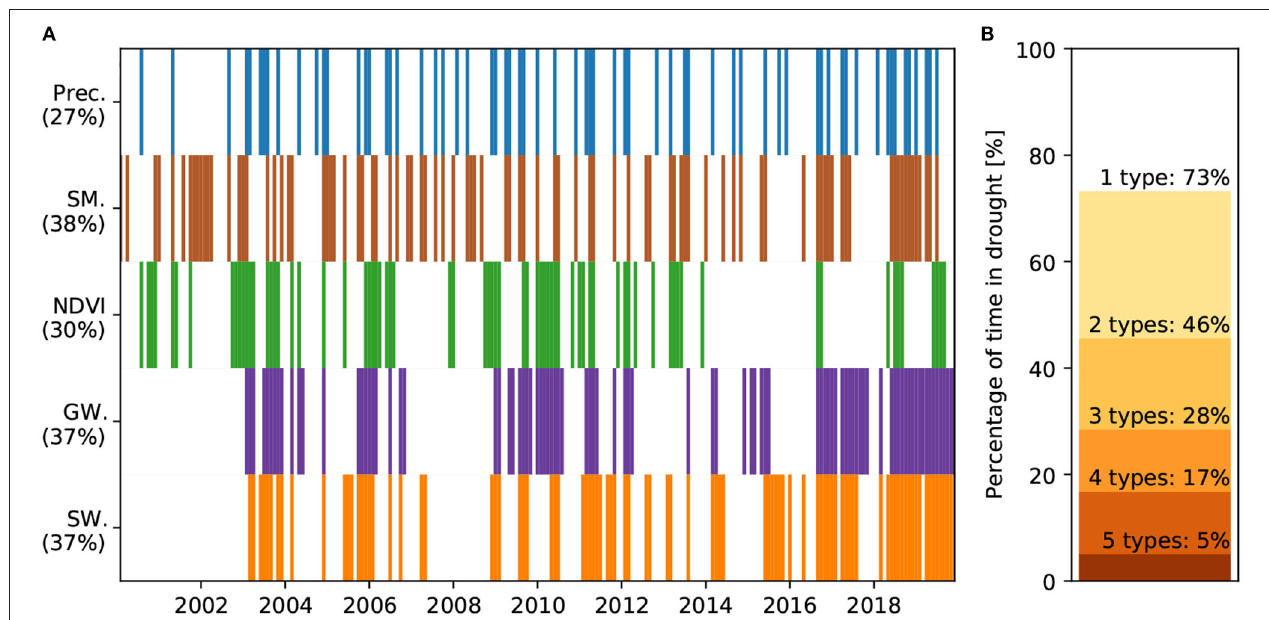
FIGURE 6 | Temporal evolution of drought conditions over the entire study period. (A) Highlights the months where the variable is considered to be in drought conditions. Percentages on the y-axis indicate the percentage of time that each variable is in drought conditions. (B) Shows the percentage of time the study area is in drought conditions, depending on how many variables are below the drought